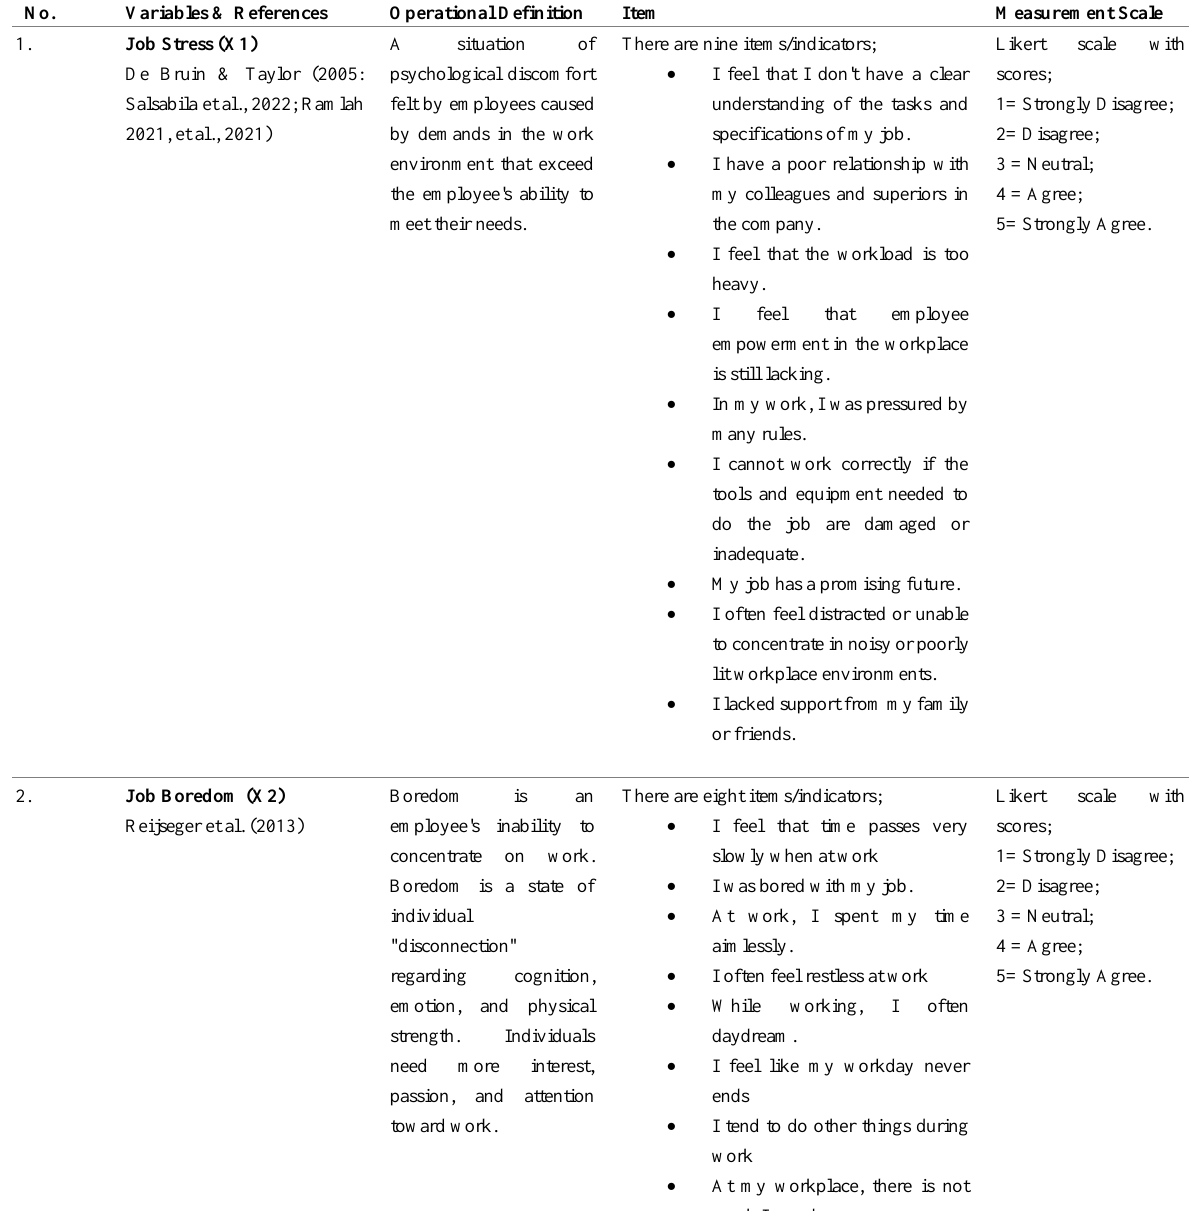
Table 1: Variables, Operational Definitions, Indicator/Items, and Measurement